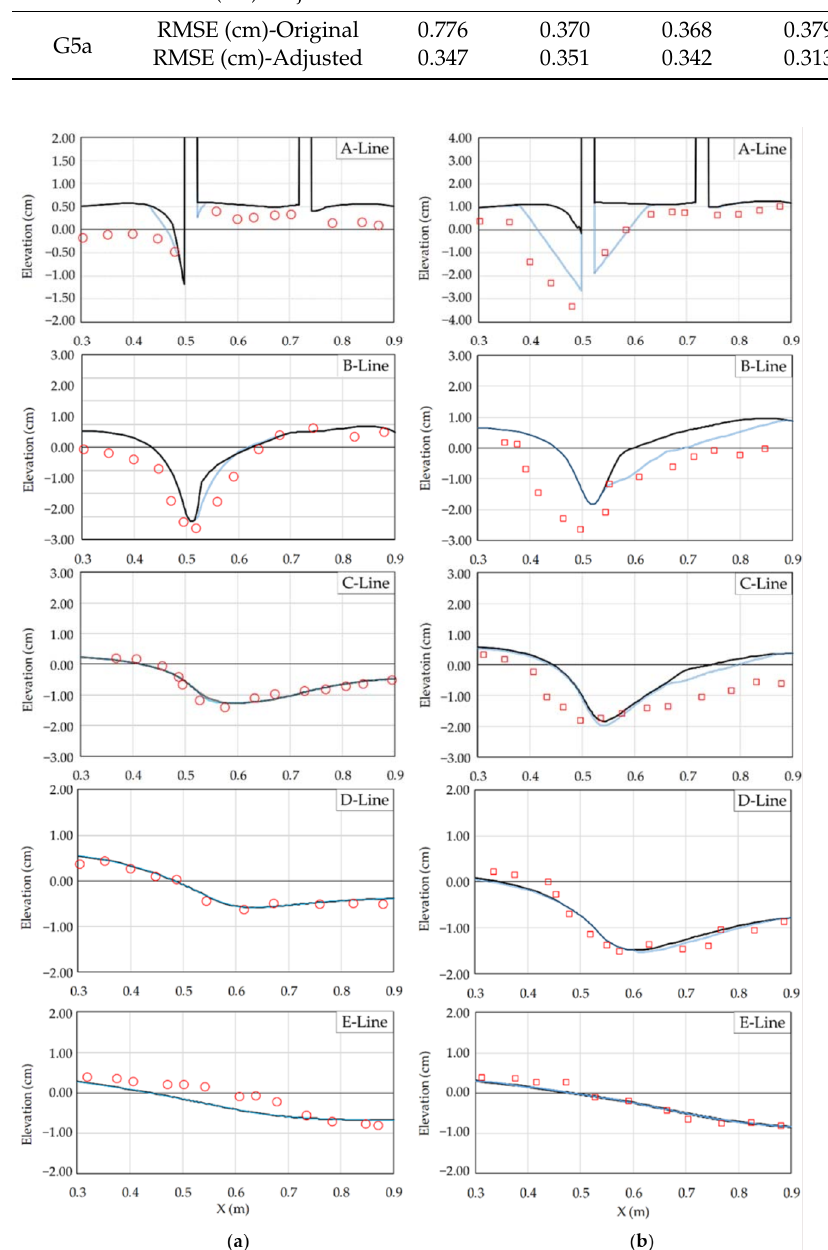
Figure 18. Local view of the comparison of the measured and simulated bed profiles at the A-line and E-line: ( a ) case G4a and ( b ) case